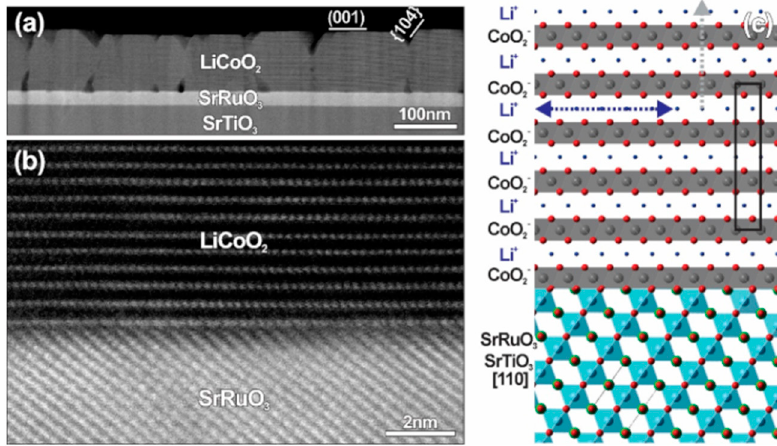
Figure 5. ( a ) High-angle annular dark-field scanning TEM (HAADF-STEM) overview showing epitaxial LCO film on (111) SRO, with growth facets forming the top surface; ( b ) HAADF-STEM imaging of the LCO/SRO interface that supports epitaxial relationship; ( c ) Structure model of the LCO/SRO interface. (This figure was previously included in our published work, see Ref. [13]).